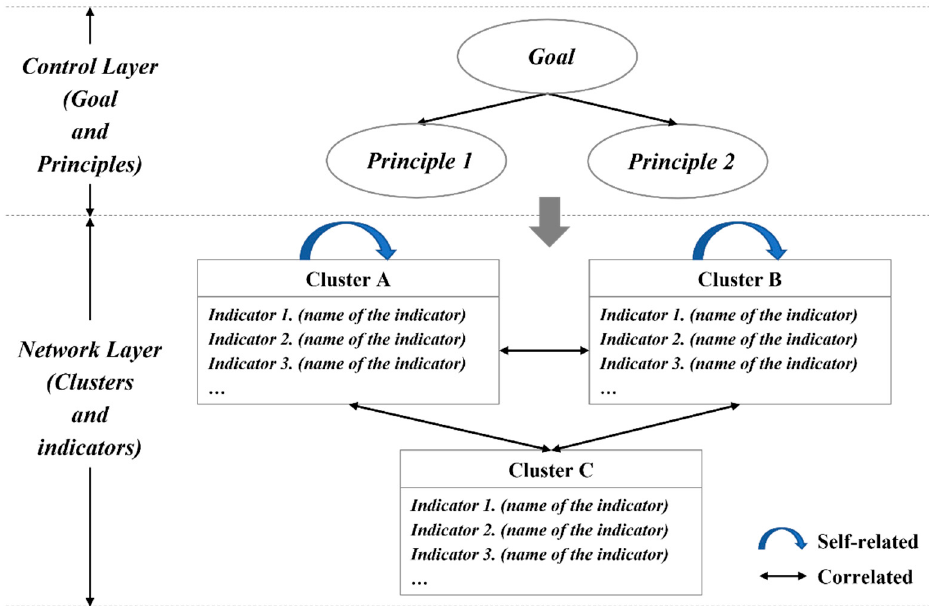
Figure 2. A typical ANP framework and process (illustrated by the authors) [25].